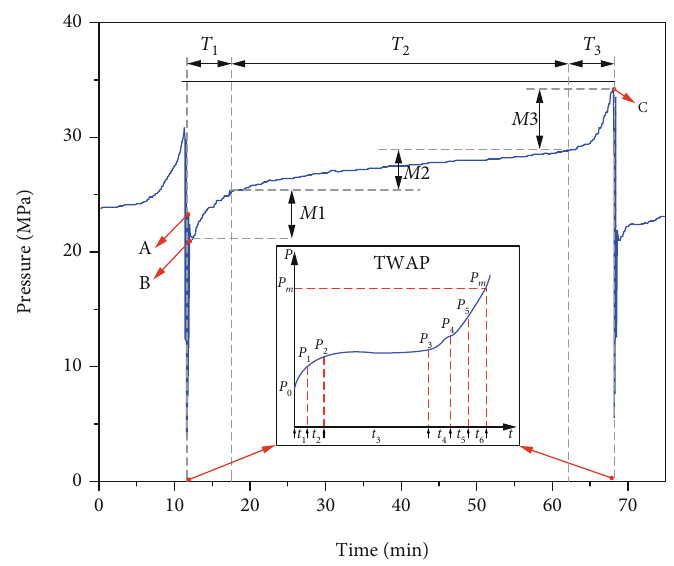
Figure 4: Shield supporting cycle